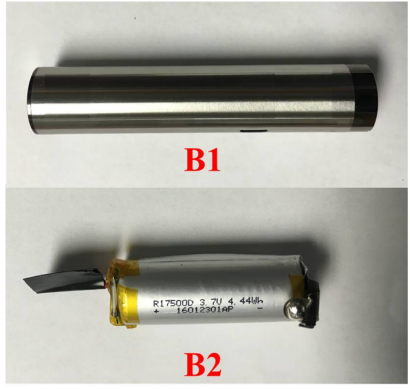
Figure 16. Photo of the e-cigarette battery holder (B1) and the built-in cell